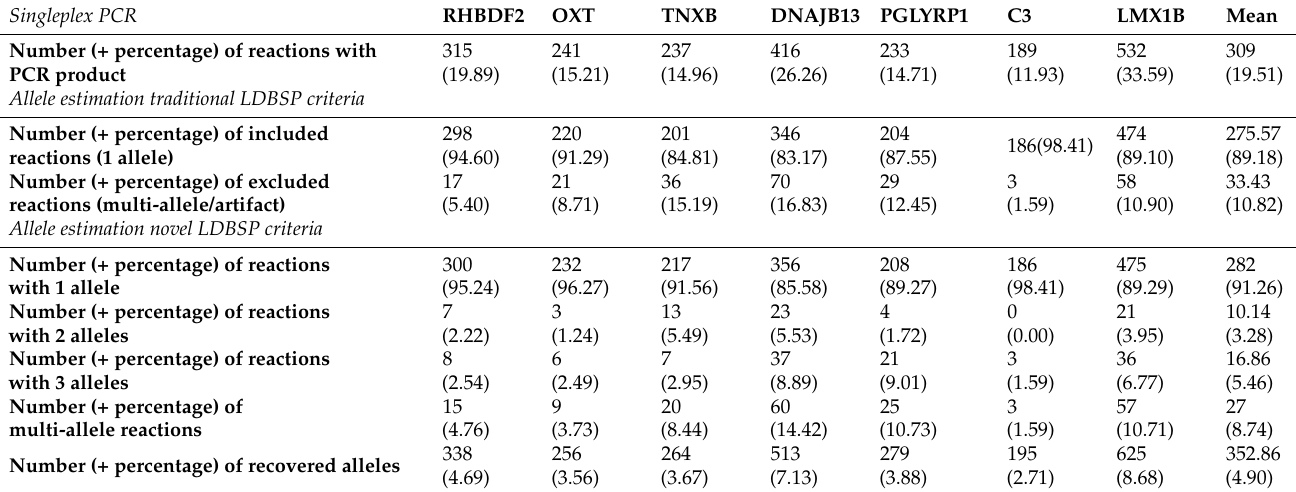
Table 1. Overview of the limiting dilution bisulfite pyrosequencing (LDBSP)